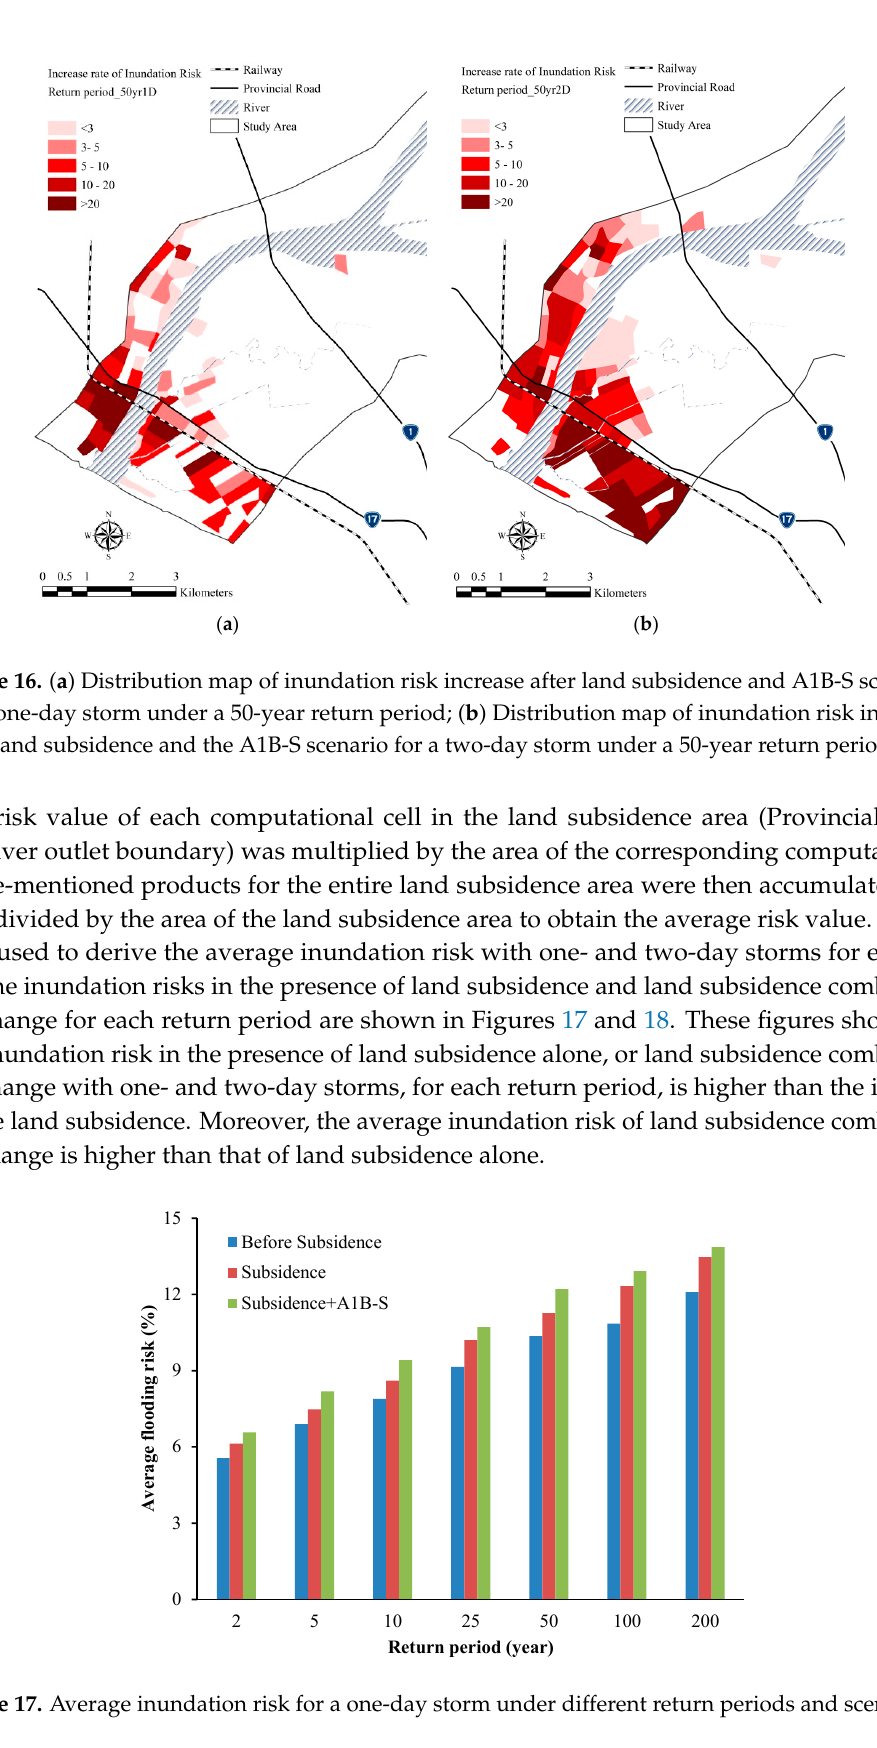
Figure 18. Average inundation risk for a two-day storm under different return periods and scenarios. 5. Conclusions An inundation risk evaluation model was developed using a PDI model, integrated with inundation depth, duration, and vulnerability. The inundation risk evaluation model analysed the impacts of land subsidence and the combination of land subsidence with climate change on inundation depth, area, volume, and inundation risk in a land subsidence-prone area. The PDI model could effectively simulate the inundation phenomenon after it was successfully validated by typhoon Morakot. The model was further applied to assess the effects of land subsidence and climate change on inundation disaster and risk. The results indicated that the inundation depth, area, and volume in the investigated area increased significantly after land subsidence; the inundation phenomenon was even worse when both land subsidence and climate change were present. Land subsidence increased not only inundation depth but also inundation duration. The average inundation duration for each return period after land subsidence was 1.05–1.1 times greater than that before land subsidence. With